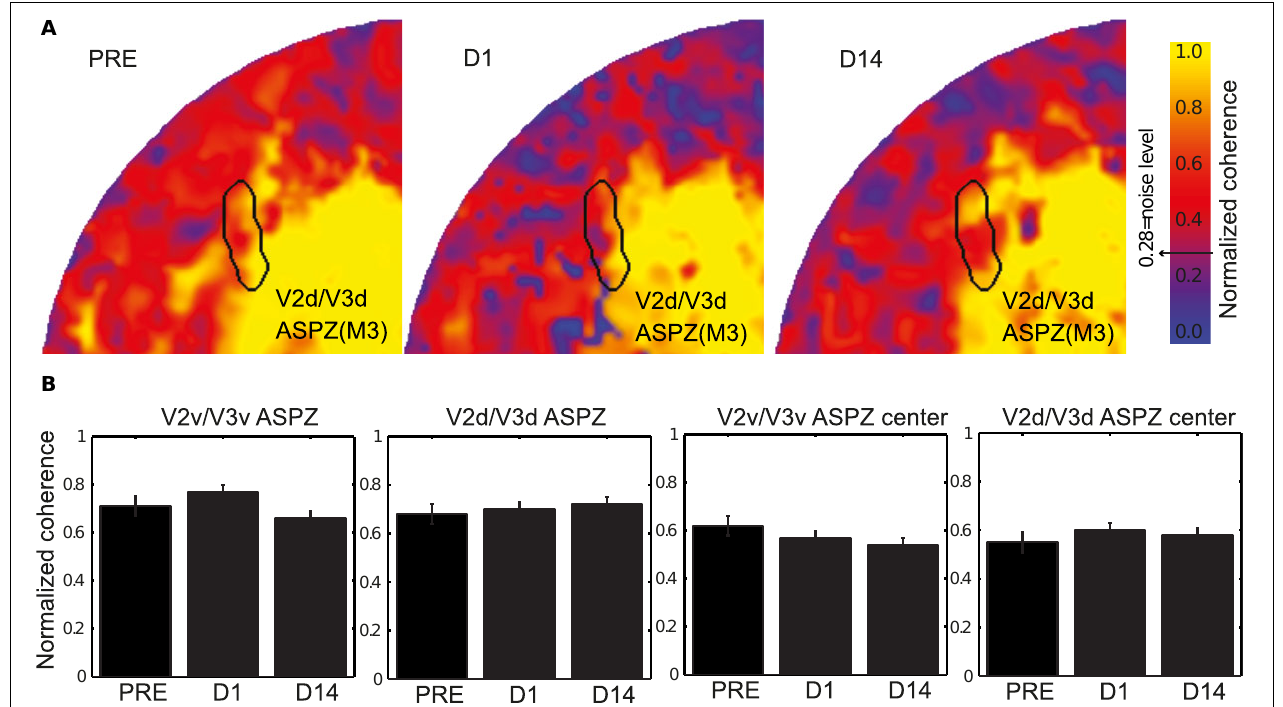
FIGURE 3 | Coherence evaluation inside the artificial scotoma projection zone (ASPZ). (A) Normalized coherence maps of M3 V2d/V3d ASPZ are presented on the flattened healthy hemisphere. (B) Evaluation of the normalized coherence values across all subjects M1-M4 and time [Pre-lesion (PRE), lesion-day (D1), and fourteen days after lesion (D14)] in the ventral and dorsal V2/V3 ASPZ. The two panels on the left present data from the complete ASPZ while the two on the right data from the center of the ASPZ. Kruskal-Wallis tests revealed no significant differences of the normalized coherence over time in all